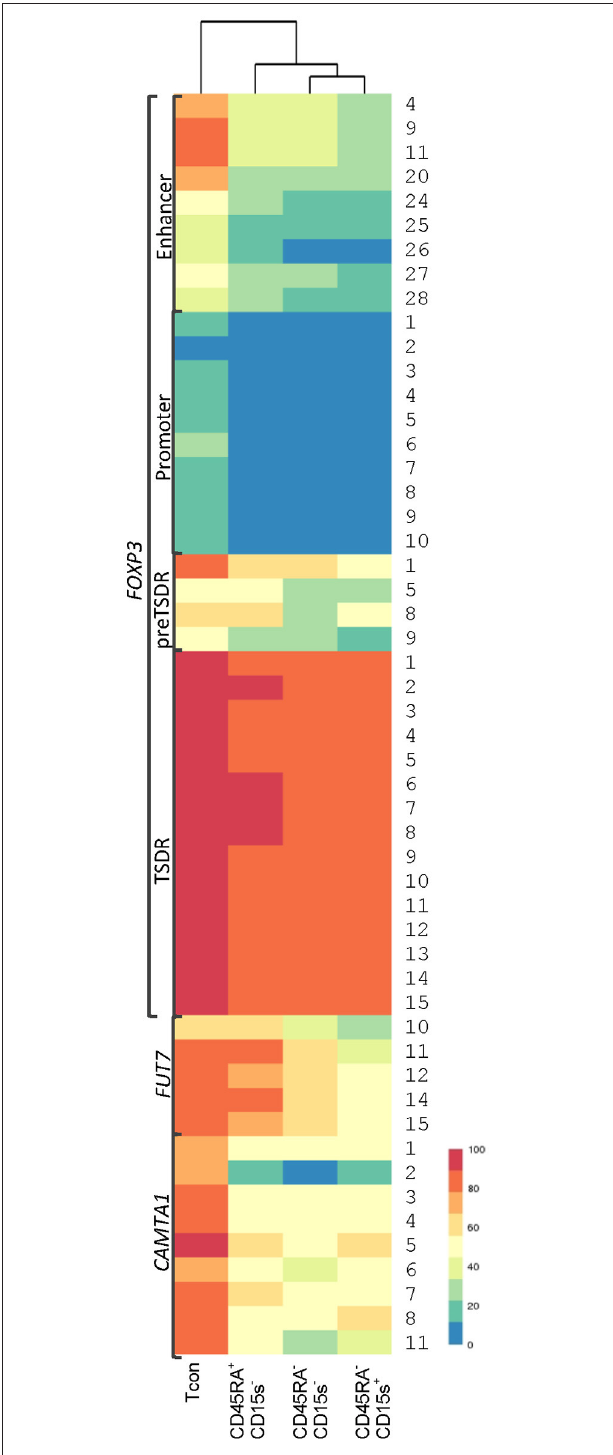
FIGURE 7 | Hierarchical clustering of Tcon and Treg (CD45RA + CD15s − , CD45RA − CD15s − , and CD45RA − CD15s + ) subtypes based on average methylation. CpG positions with striking methylation differences across the cell subtypes were further analyzed after an unbiased clustering method examining the distance of cell subtypes from each other based on average CpG methylation for each genomic element (see also Supplementary Figure 1 ). Each row corresponds to CpG positions for each genomic